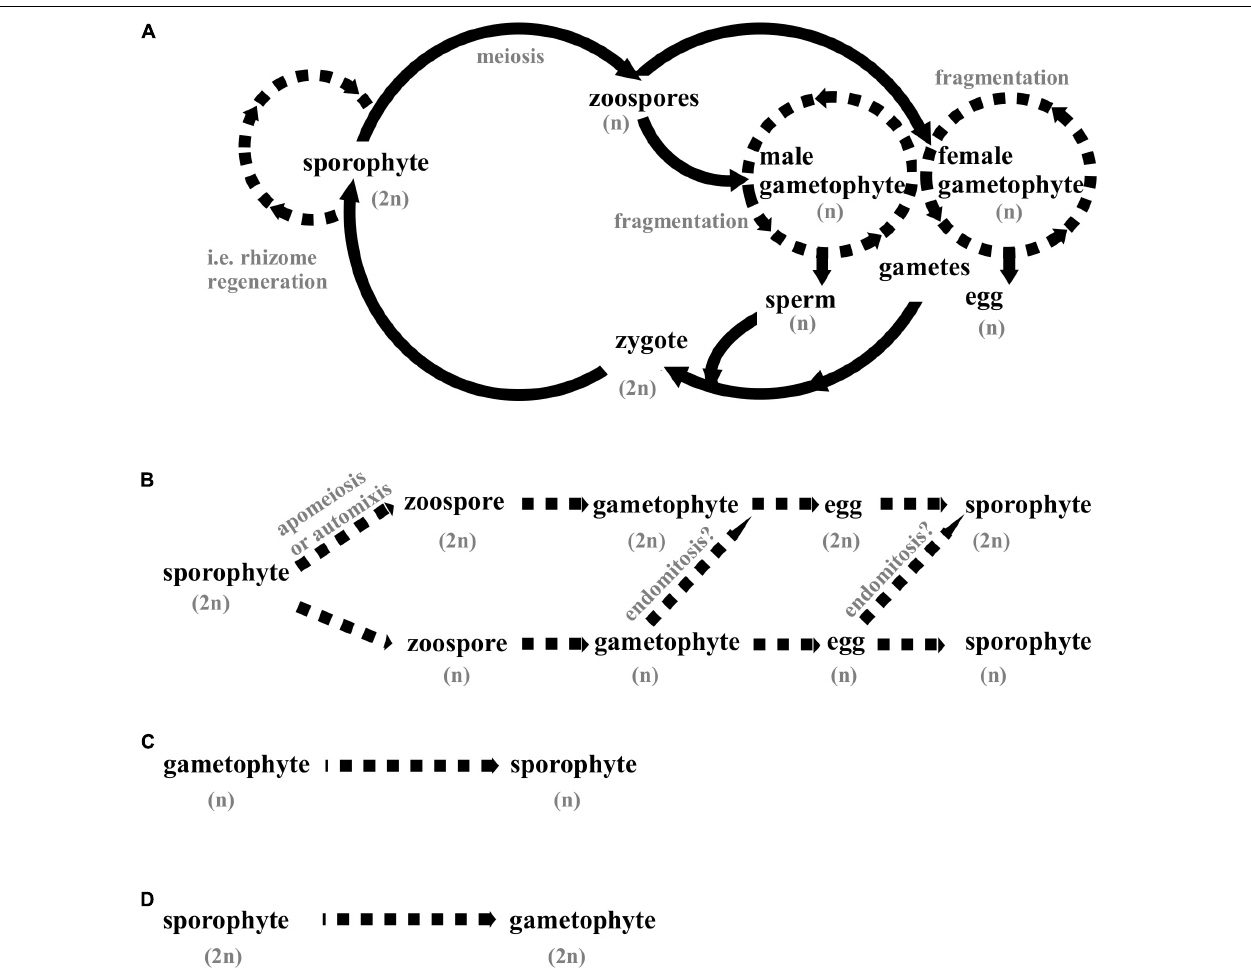
FIGURE 1 | Life cycles are of Laminarialean kelps. The possibilities for asexual reproduction are displayed with discontinued lines. n; haploid stage, 2n; diploid stage. (A) The diplohaplontic life cycle of species in the order Laminariales involves two independent and free-living states, which may look very different from each other: Macroscopic sporophytes that produce zoospores, and microscopic male and female gametophytes that produce gametes. Self-fertilization is common. Some species have vegetative reproduction of the sporophyte through rhizome expansion and outgrowth of additional blades. Under certain conditions, gametophytes can grow continuously and be vegetatively propagated through fragmentation. (B) Parthenogenesis, development of sporophytes from unfertilized female gametes. Diploidy can be generated through apomeiosis (replacement of meiosis with mitosis), automixis (two of the four nuclear products of meiosis fuse), or endomitosis (endoreduplication, spontane chromosome doubling). (C) Apogamy, development of sporophytes from somatic cells of gametophytes. (D) Apospory, development of gametophytes from somatic cells of